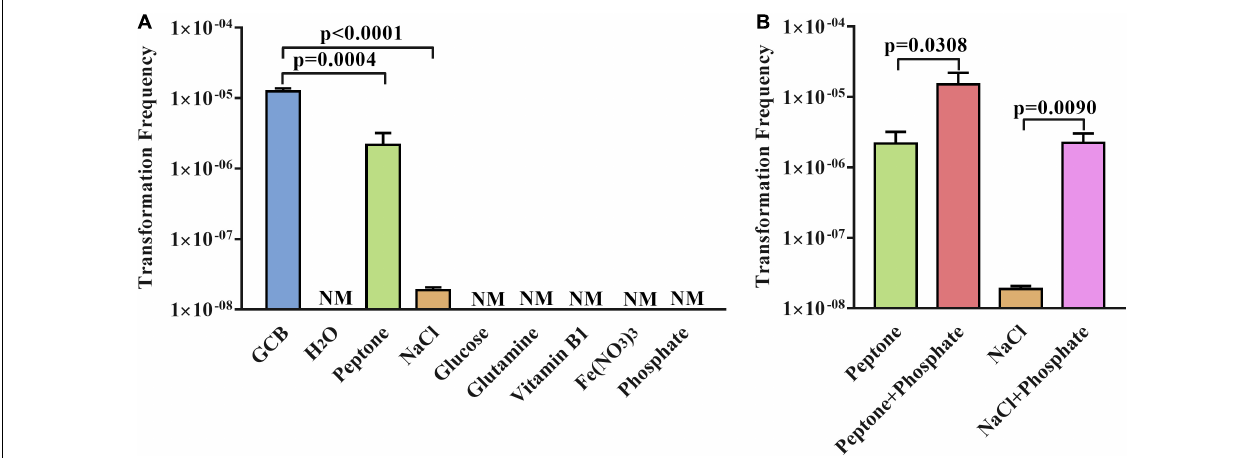
FIGURE 3 | The natural transformation frequency of R. anatipestifer ATCC 11845 in sterile H 2 O supplemented with single components or double components of GCB. (A) The transformation assay of R. anatipestifer ATCC 11845 in sterile H 2 O 2 supplemented by a single component of the GCB medium. The bacteria were grown to the exponential phase in the GCB medium; then, they were resuspended to an OD 600 of 1 in fresh GCB medium, sterile H 2 O, sterile H 2 O supplemented with glucose, L-glutamine, vitamin B1, Fe (NO 3 ) 3 , NaCl, phosphate, and peptone, respectively. Following preincubation at 37 ◦ C for 1 h with shaking, the bacterial suspensions (0.3 ml) were used to perform the natural transformation assay as described in section “Materials and Methods.” (B) Natural transformation assay of R. anatipestifer ATCC 11845 in sterile H 2 O containing peptone, NaCl, peptone and phosphate, NaCl and phosphate, respectively. The bacteria were grown to the exponential phase in the GCB medium, then, they were resuspended to an OD 600 of 1 in sterile H 2 O supplemented with peptone, peptone and phosphate, NaCl, and NaCl and phosphate, respectively. Following preincubation at 37 ◦ C for 1 h with shaking, the bacterial suspensions (0.3 ml) were used to perform the natural transformation assay as described in section “Materials and Methods.” NM represents no